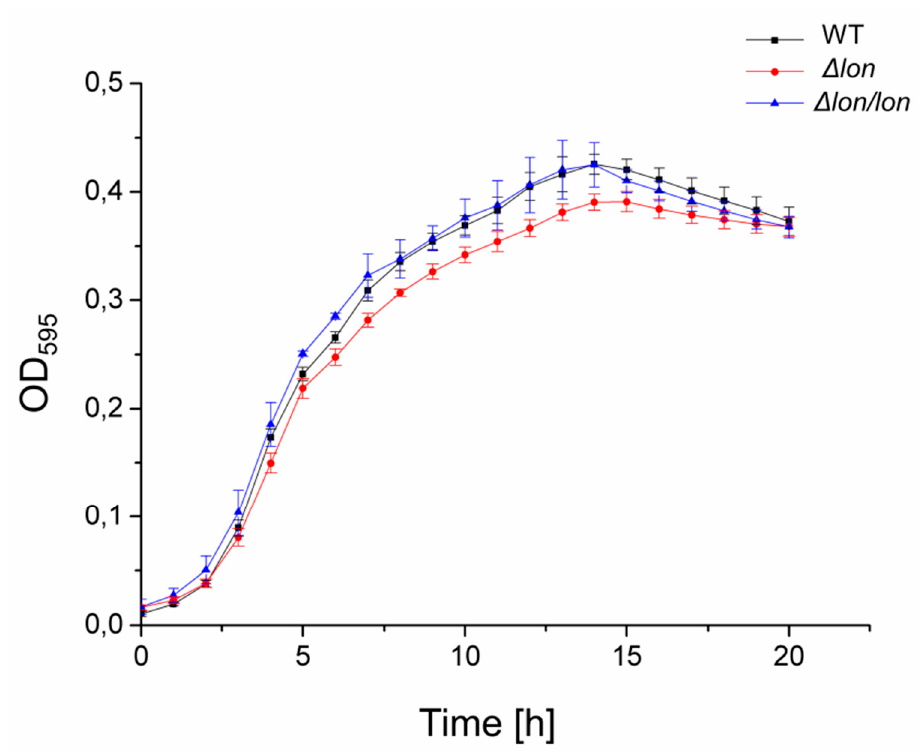
Figure 2. Growth of D. solani ∆ lon. Curves were determined with the use of a plate reader at 30 ◦ C. OD 595 (optical density (595 nm)) values in LB medium were averaged for four replicates.